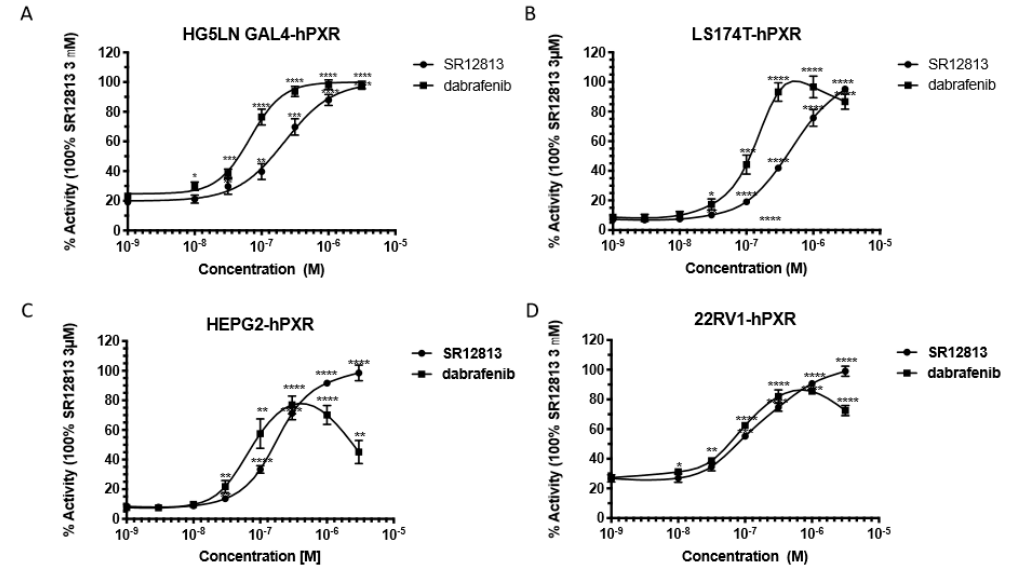
Figure 2. Dabrafenib is a potent activator of hPXR on di ff erent human cancer cell lines. Results of luciferase assays showing dose–response curves for SR12813 and dabrafenib in ( A ) HG5LN GAL4-hPXR, ( B ) LS174T-hPXR, ( C ) HepG2-hPXR and ( D ) 22RV1-hPXR reporter cell lines. Results are expressed as a percentage of the maximal response obtained in the presence of 3 µ M SR12813. Data are the mean ± sd of three to five independent experiments, **** p < 0.0001, *** p < 0.001, ** p < 0.01 (Student’s t-test) compared with DMSO- treated cells.3.2. Time-Resolved Fluorescence Energy Transfer Experiments.